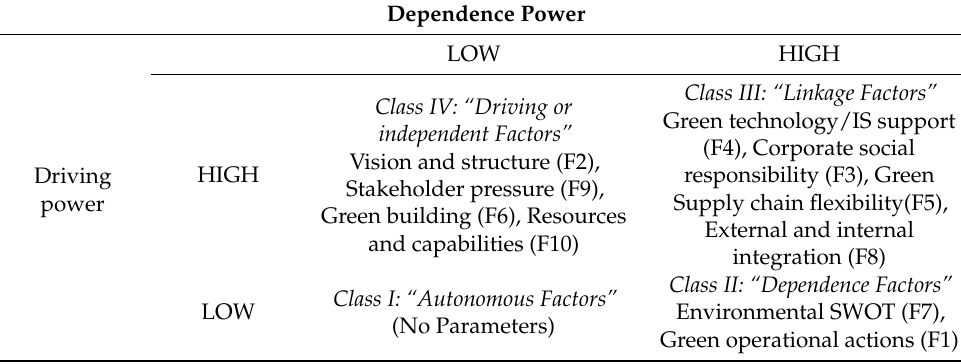
Table 5. Identified factors into MICMAC categories.